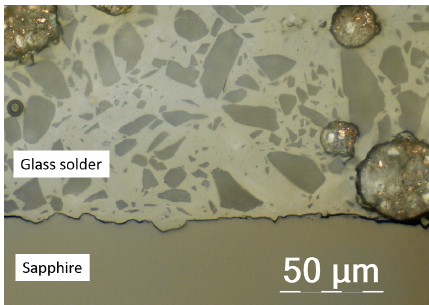
Figure 16. Cross section of glass solder on rough sapphire back- side, with a surface roughness of S a = 1.5µm (sapphire).